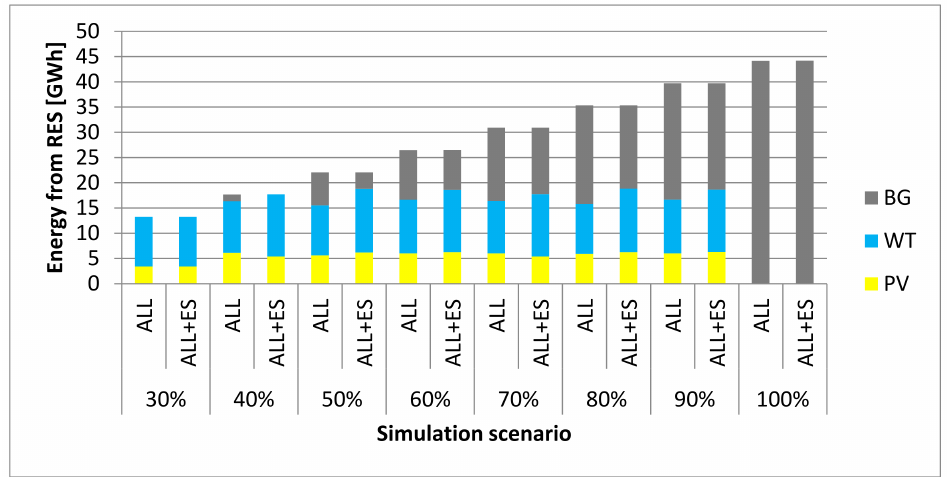
Figure 8. Energy structure for simulation scenarios.